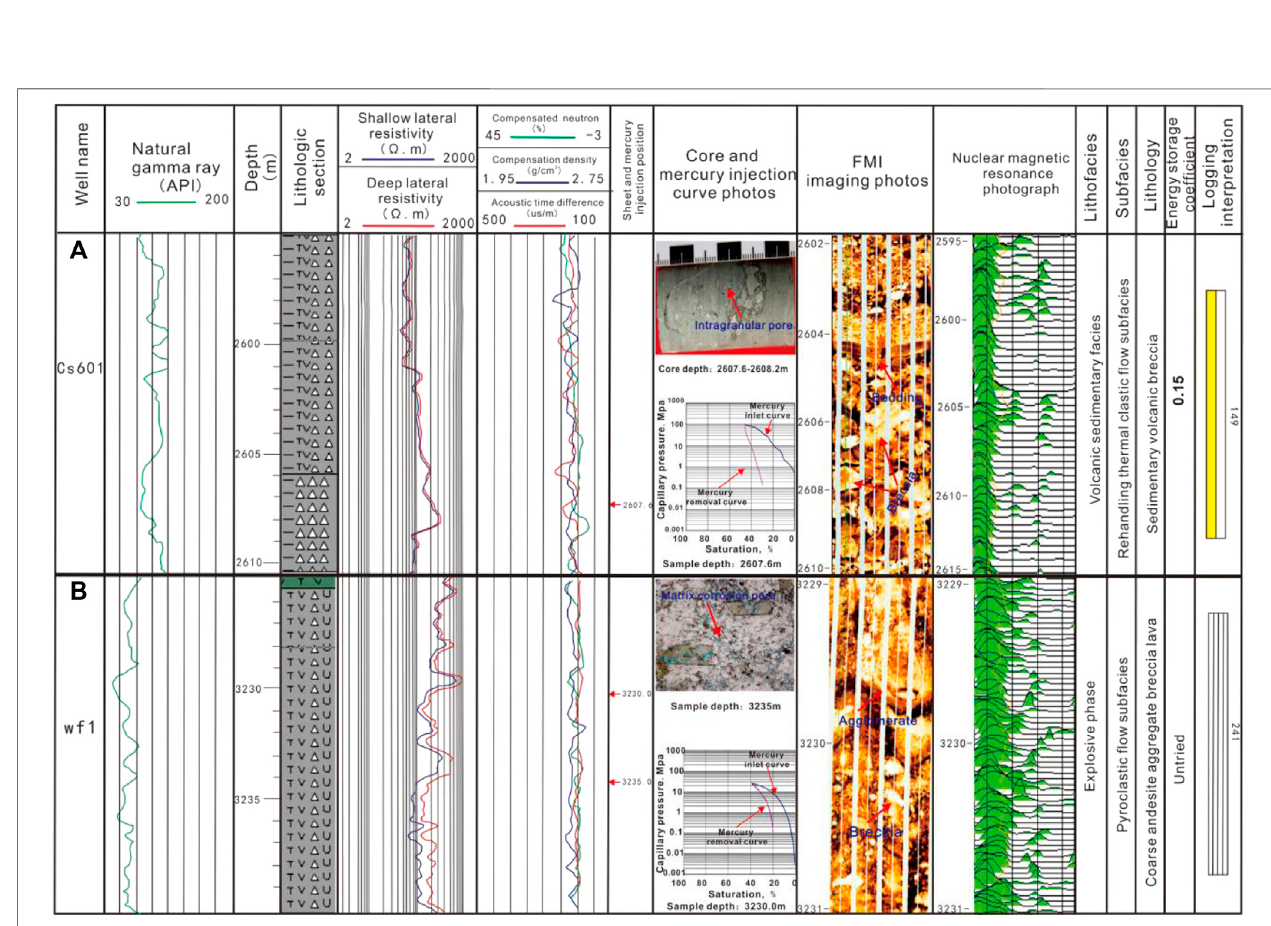
FIGURE 11 | Typical logging evaluation map of Type III volcano reservoir in the Wangfu Gas Field. Notes: (A) Well Cs601; (B) Well wf1.